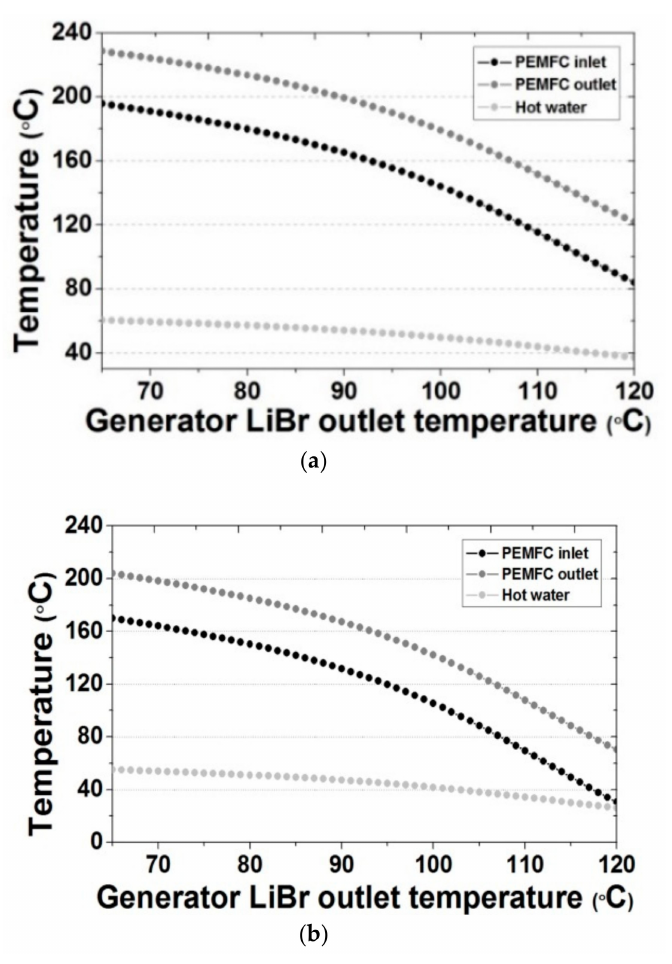
Figure 7. Comparison of PEMFC in / out TEG and hot water temperature according to the temperature of the LiBr solution at the generator outlet of absorption cooling system. ( a ) Absorption cooling capacity: 2.0 kW; ( b ) Absorption cooling capacity: 2.5 kW.